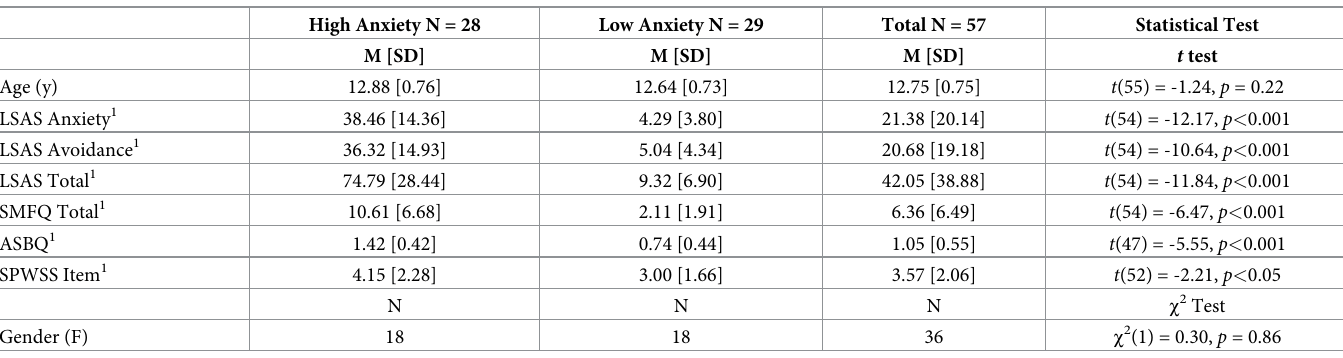
Table 1. Descriptive statistics of